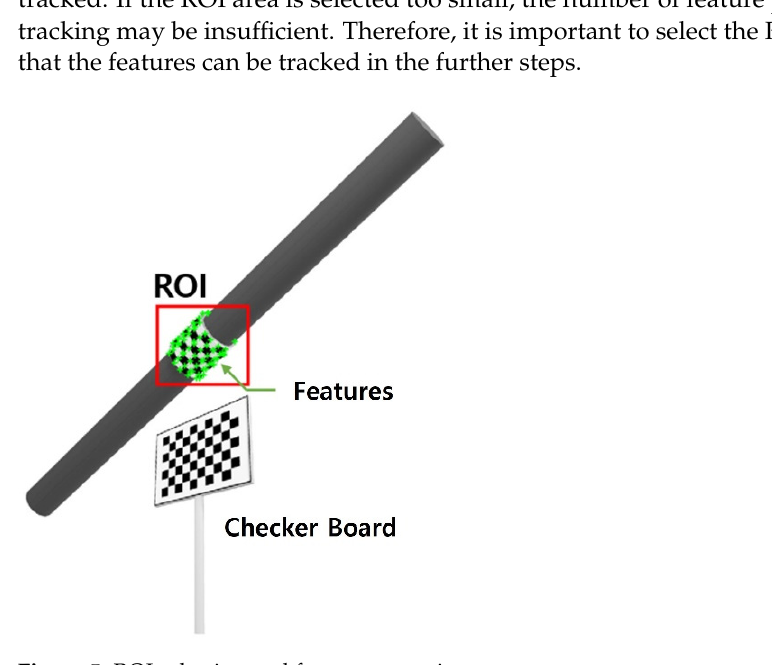
Figure 5. ROI selection and feature extraction.